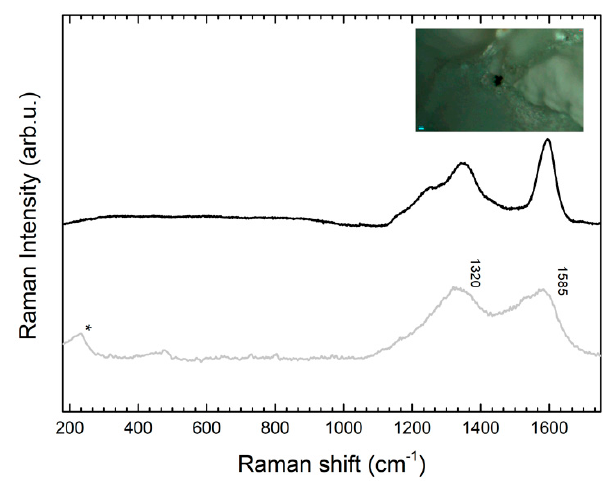
Figure 8. SERS spectrum (grey line) of a sample of the black pigment from area 4 collected with GT-SERS, compared with the Raman spectrum of a carbon black reference sample obtained with the same instrument (black line).